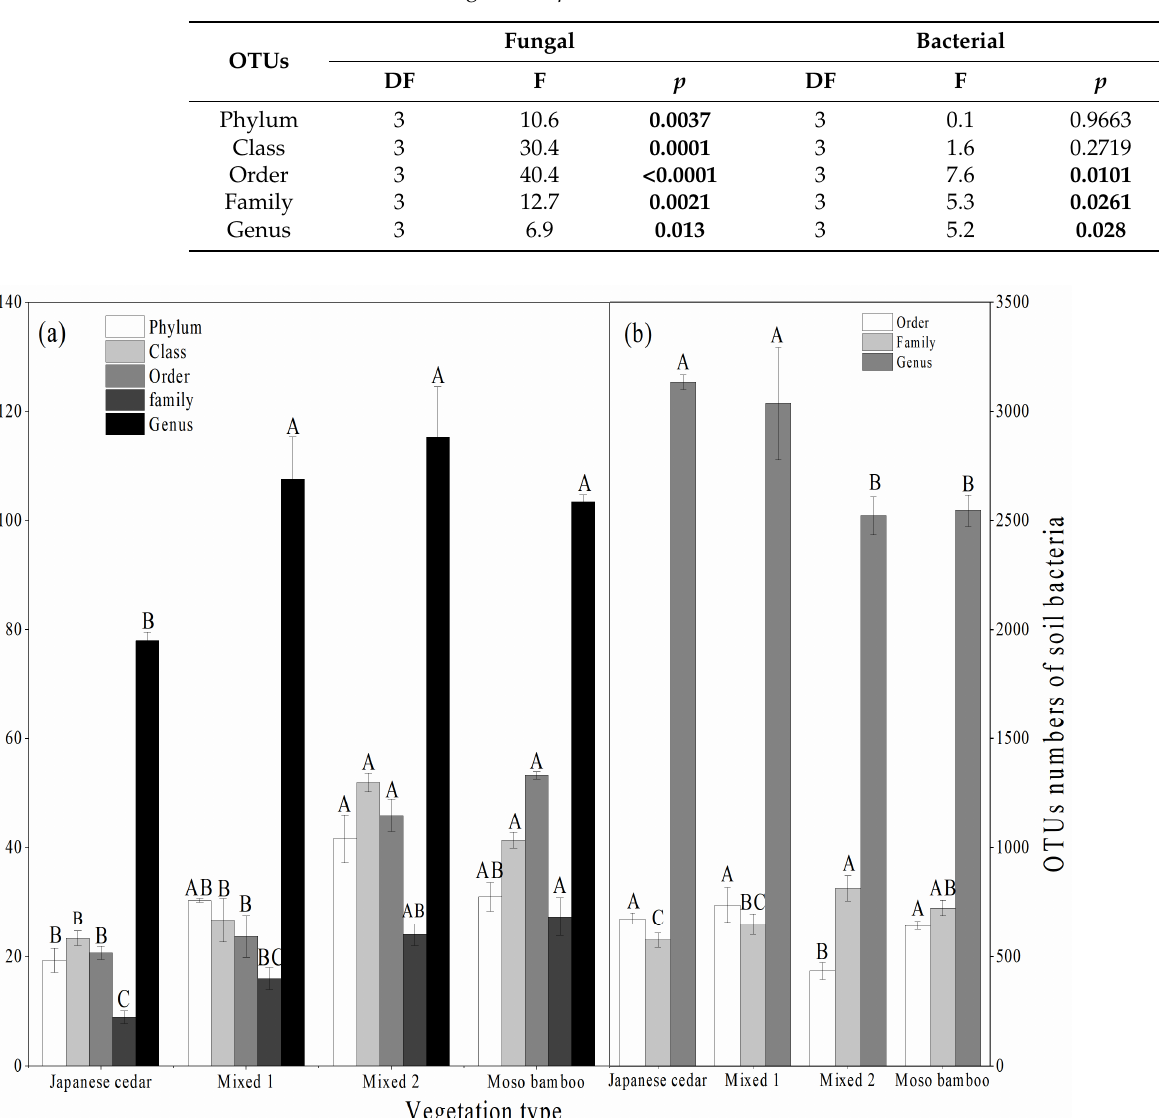
Table 2. Effect of moso bamboo expansion on the number of OTUs of soil microbial fungi and bacteria in ANOVAs. Results with significant p values are shown in bold.